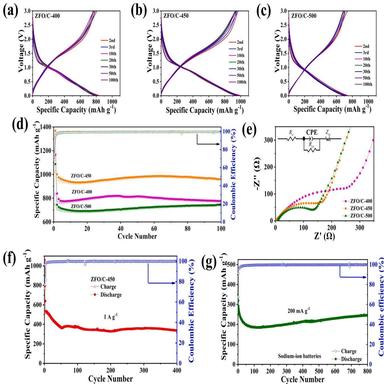
Charge-discharge curves at different cycles of (a) ZFO/C-400, (b) ZFO/C-450, and (c) ZFO/C-500 at 200 mA g–1; (d) Cycle performance and (e) EIS curves of all the samples; (f) Cycle performance of ZFO/C-450 at 1 A g–1; (g) Cycle performance of ZFO/C-450 at 200 mA g–1 when applied as an anode material of Na-ion battery.